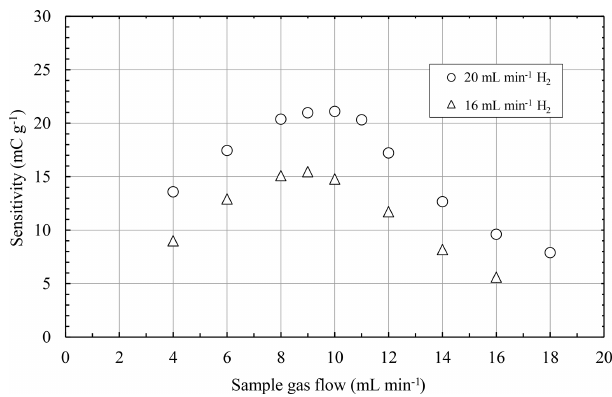
Figure 4. Sensitivity of the µFID as a function of the sample gas flow for different burning gas flows.